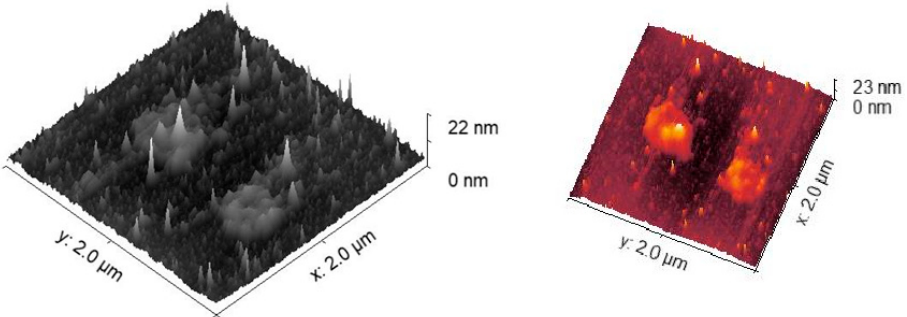
Figure 3. AFM height maps of pristine LB films of 1 . The number of layers is 4. The two images are different representations of the same AFM area scan. See text for details.